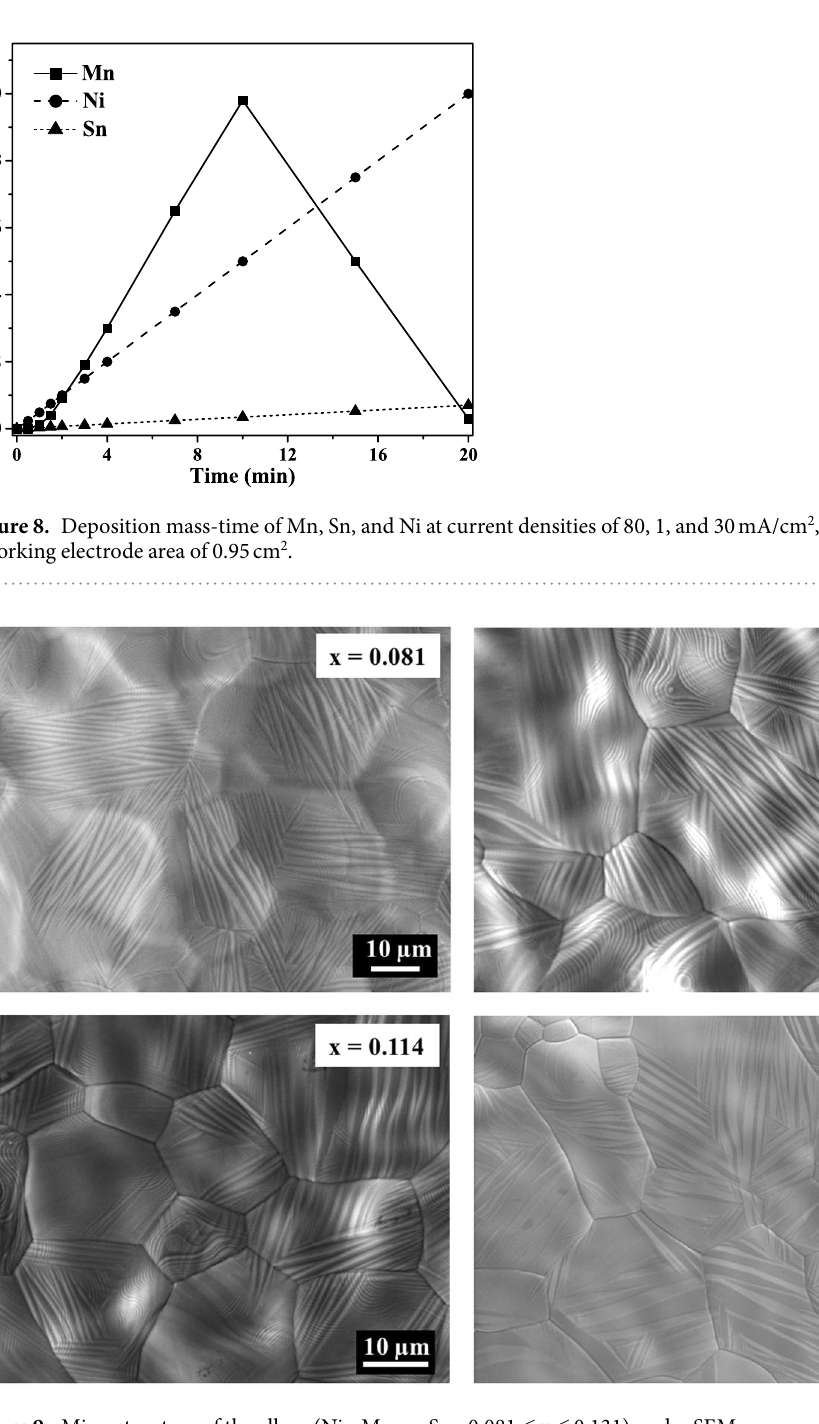
Figure 9. Microstructure of the alloys (Ni 0.5 Mn 0.5 − x Sn x , 0.081 ≤ x ≤ 0.131) under